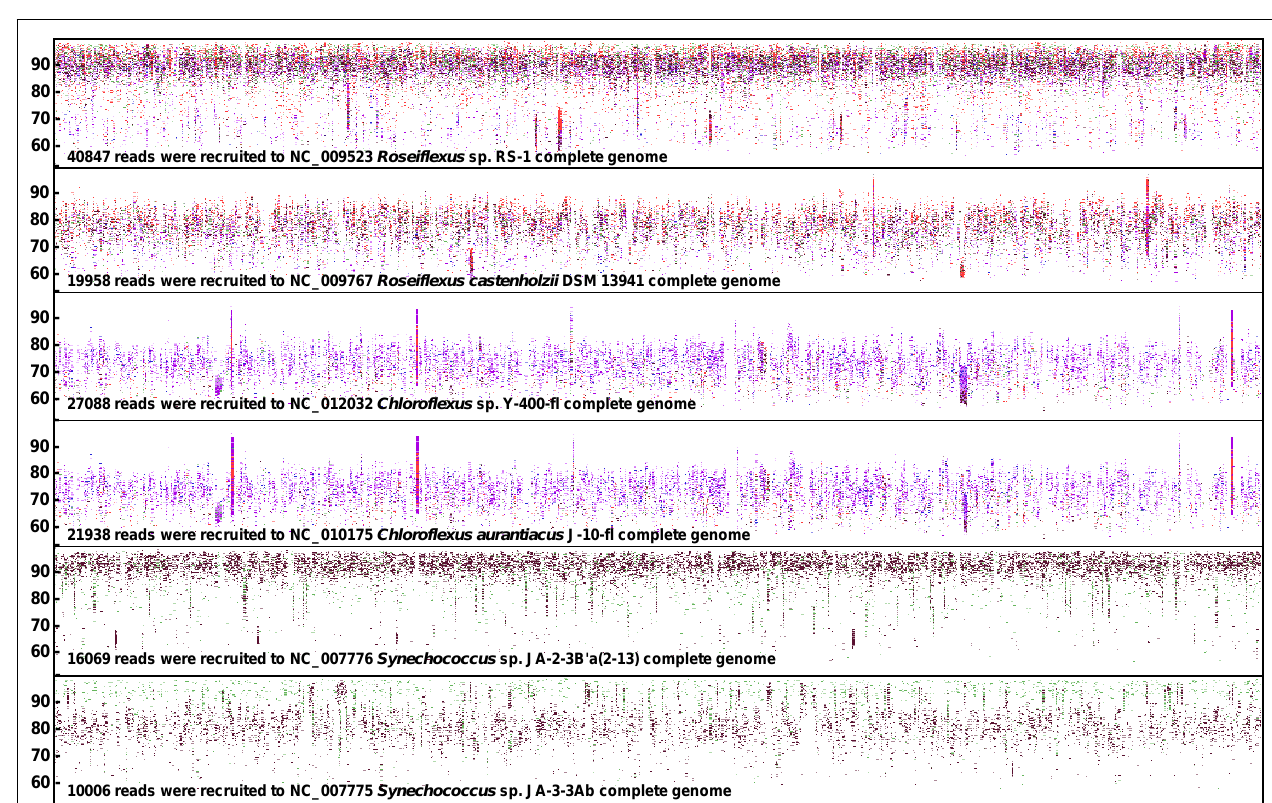
(FG_16) = red; Bath LakeVista Annex (BLVA_5 and 20) = light and dark purple, respectively. Reference genomes: Synechococcus sp. B (cid:48) (JA-2-3B (cid:48) a) and A (JA-3-3Ab); Chloroflexus spY-400-fl and C. aurantiacus J-10-fl; Roseiflexus sp RS-1 and R. castenholzii DSM 13941 (Plot constructed using JCVI bioinformatic utilities; Rusch et al.,